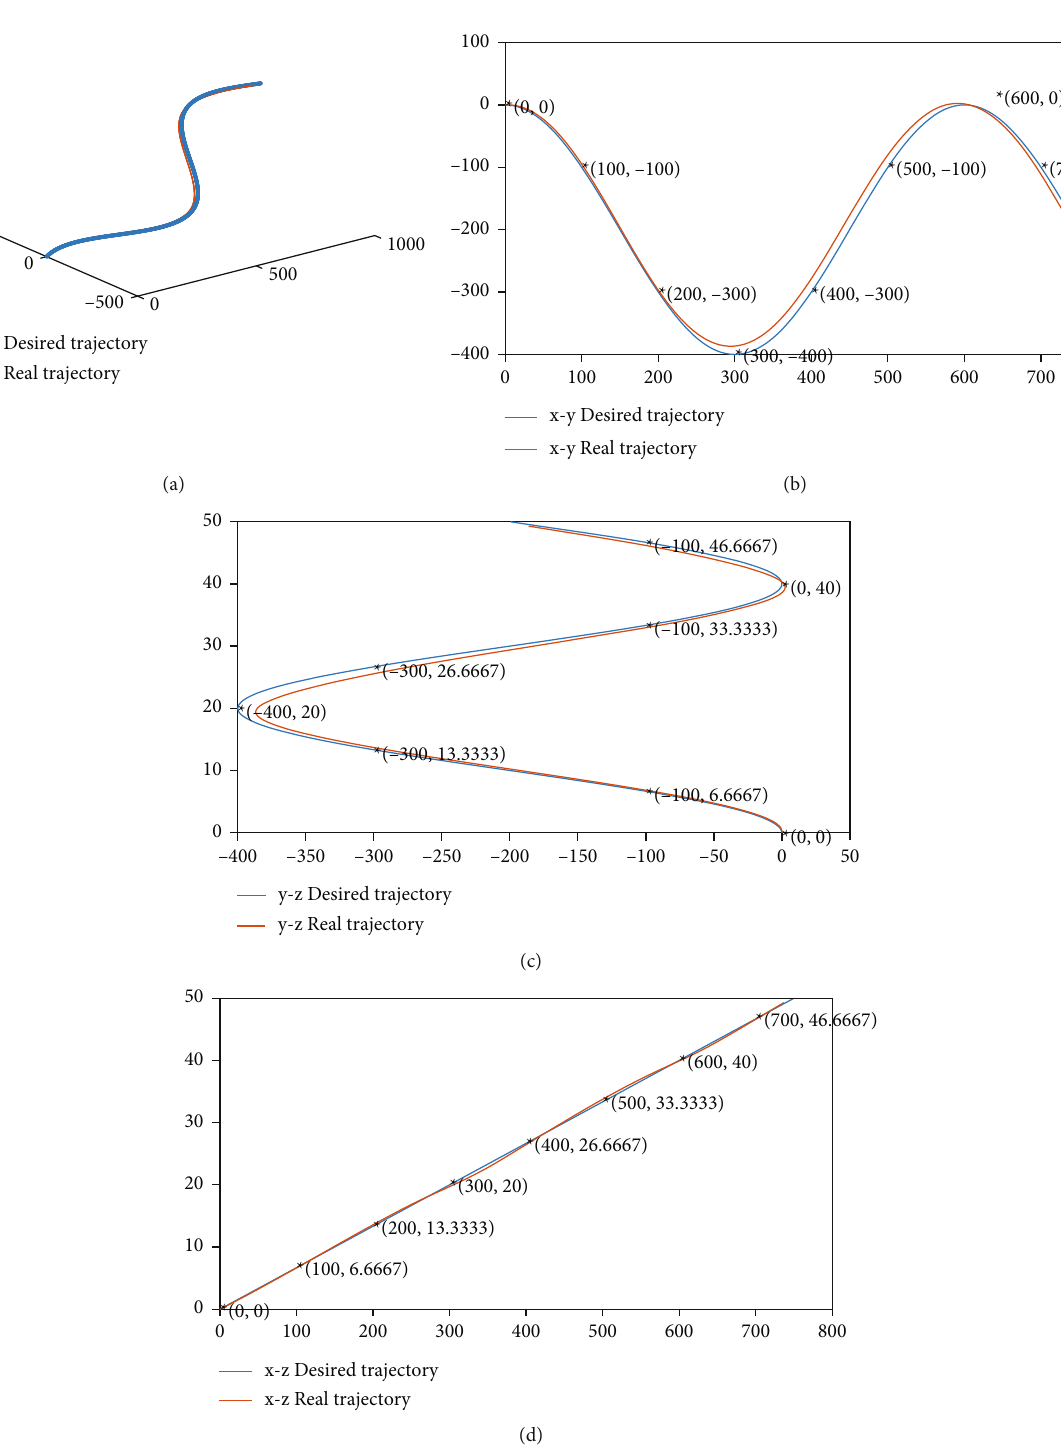
Figure 17: S control trajectory: (a) in the 3D space; (b) in the x - y plane; (c) in the y - z plane; (d) in the x - z